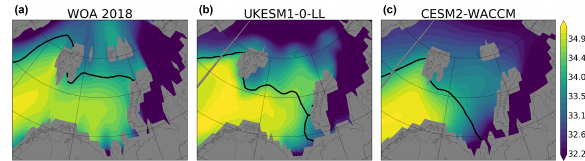
Figure 7. Annual mean sea surface salinity in the Barents Sea and its neighbouring waters from (a) the World Ocean Atlas 2018 and from the CMIP6 model with the (b) highest (UKESM1-0-LL) and (c) lowest (CESM2-WACCM) maximum sea surface density and salinity. The 0 ◦ C isotherm indicates approximately the extent of Atlantic waters (black solid